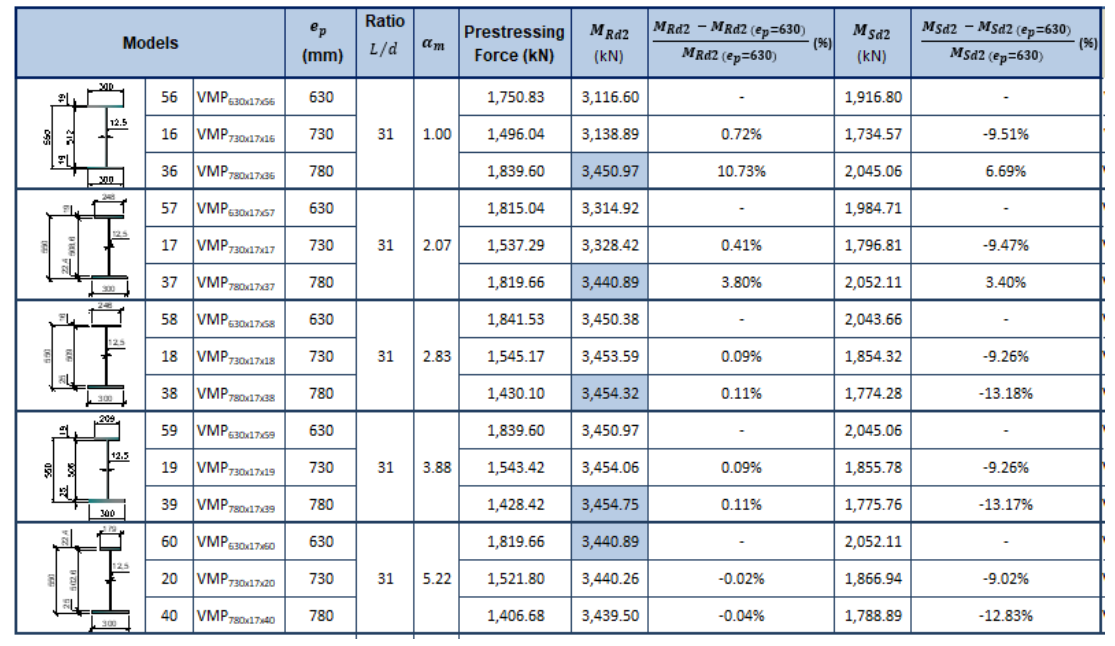
Figure 14. Eccentricity influence - / L d ratio =